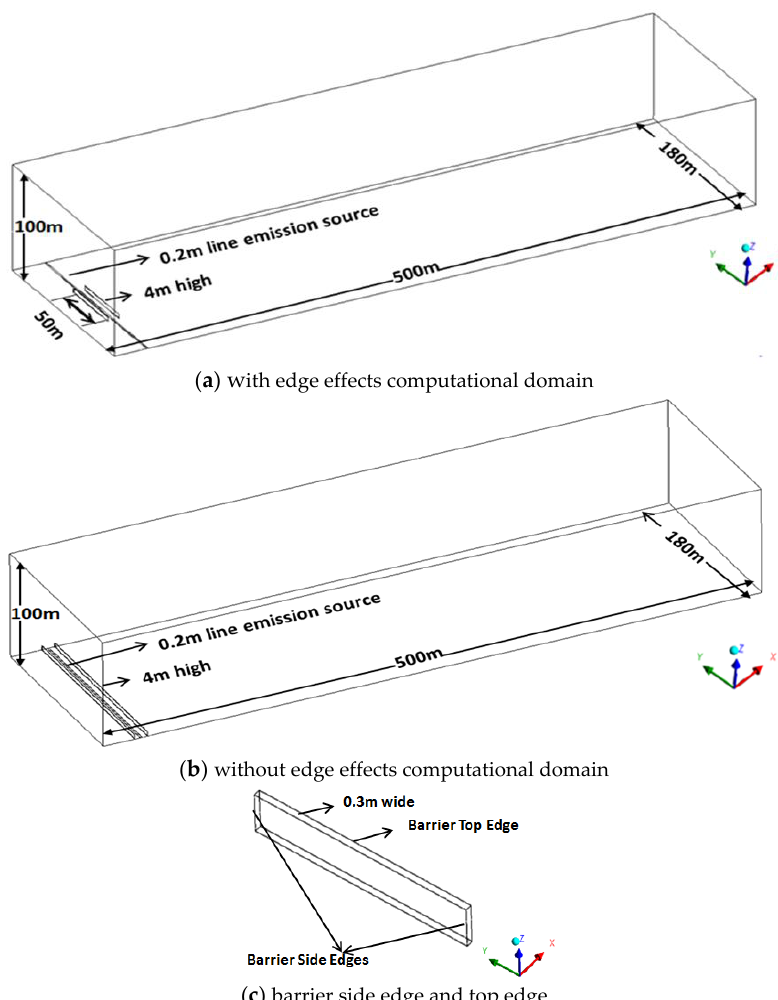
Figure 1. Computational domain for noise barriers ( a ) with edge effects, ( b ) without edge effects, and ( c ) close view of the noise